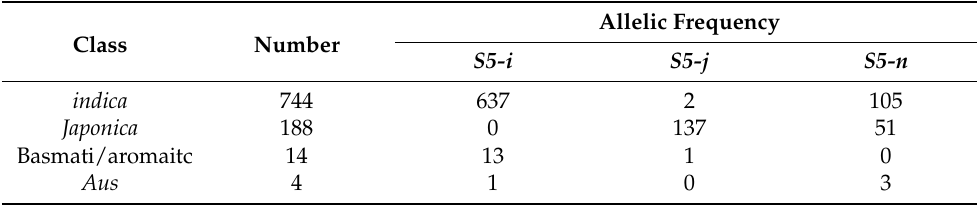
Table 1. Distribution of S5 alleles in the germplasm